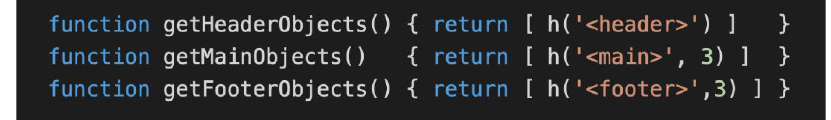
Figure 3. Code implementation for the default layout. The getHeaderObjects , getMainObjects and getFooterObjects are implemented. Each one returns a header tag containing the tag name for the corresponding